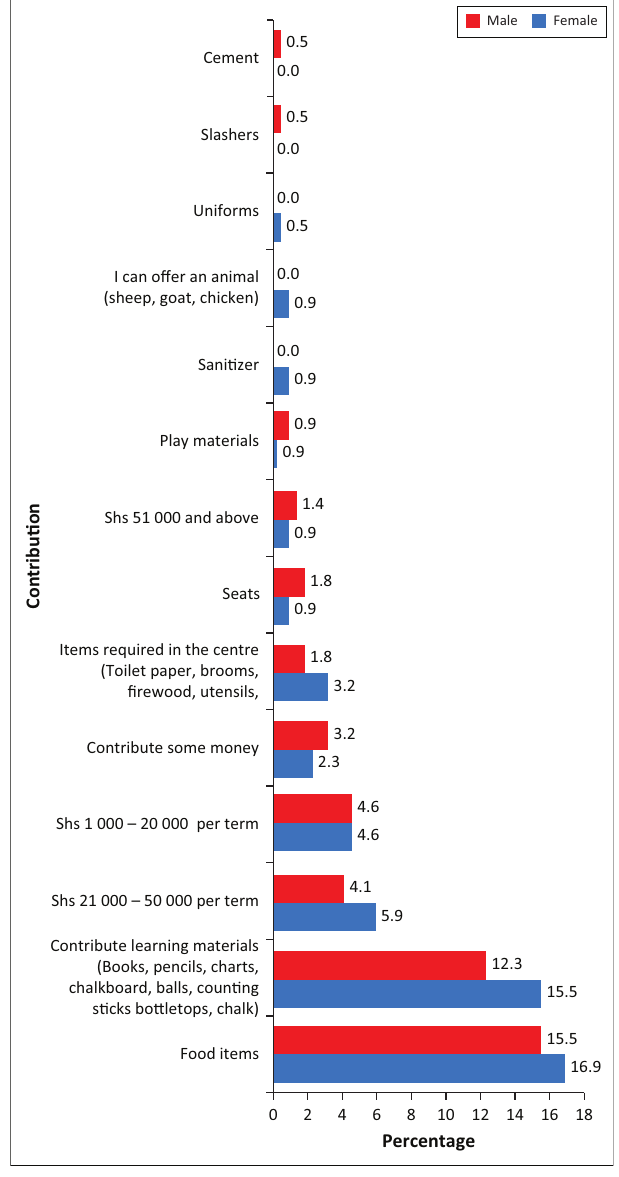
FIGURE 5: What parents are willing to offer to the home based learning centre by